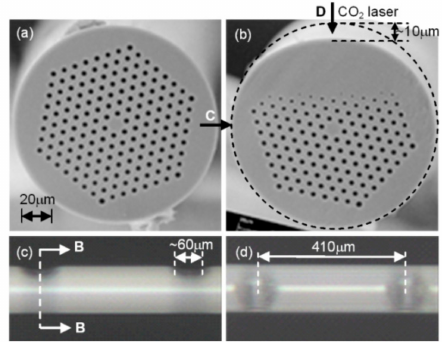
Figure 6. Scanning electron micrographs of the employed photonic crystal fiber (PCF) ( a ) before ( b ) after CO 2 laser irradiation; ( c , d ) micrographs of the obtained asymmetrical SLPFG with periodic grooves